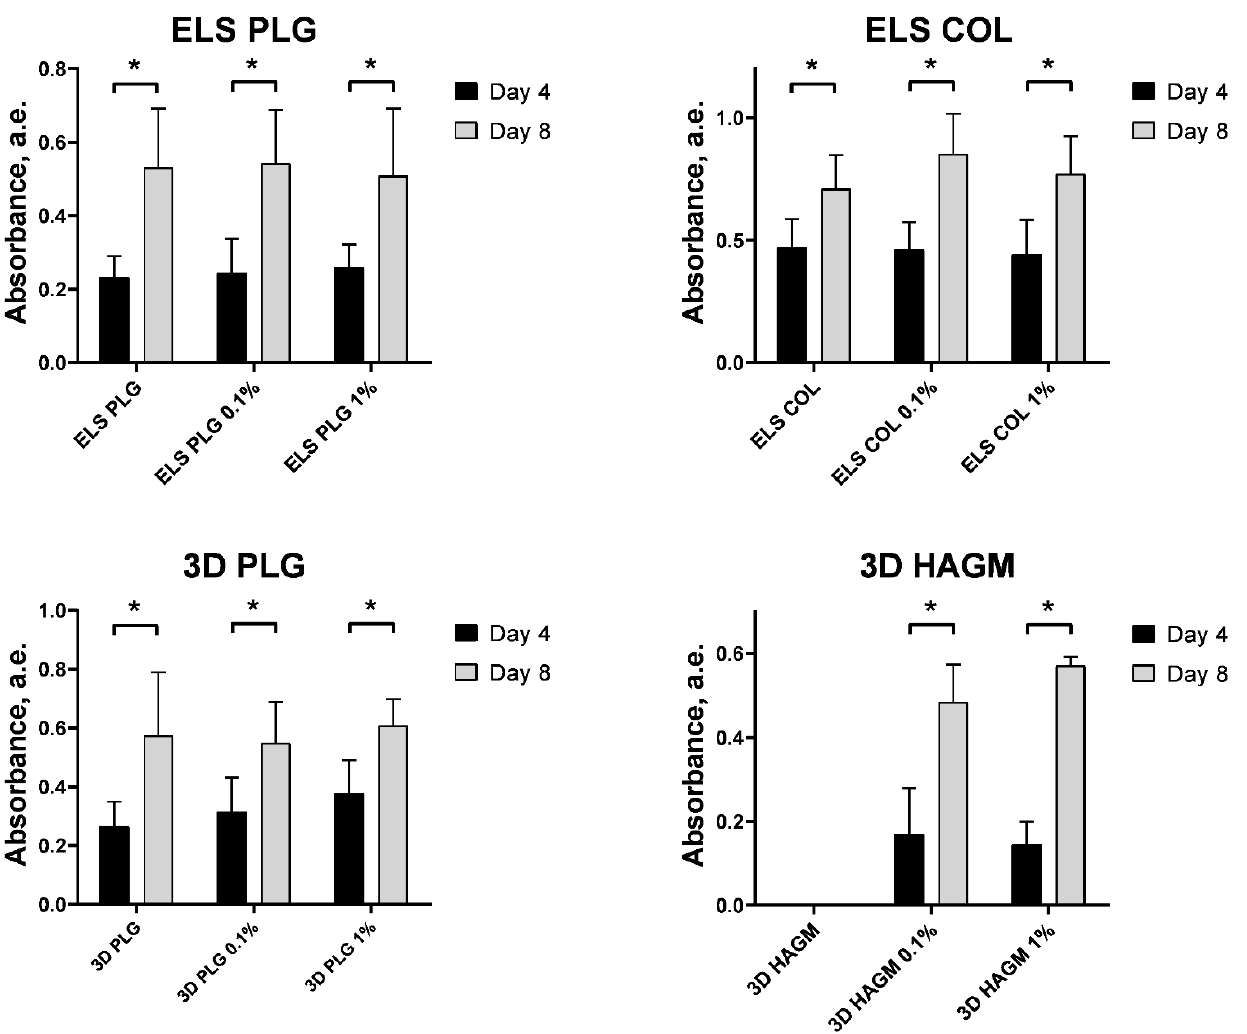
Figure 11. The growth of Bj-5ta fibroblasts on the UCNPs-loaded scaffolds, 4 and 8 days of incubation. Data are the mean ± SD, * p < 0.05 in Mann–Whitney U test.